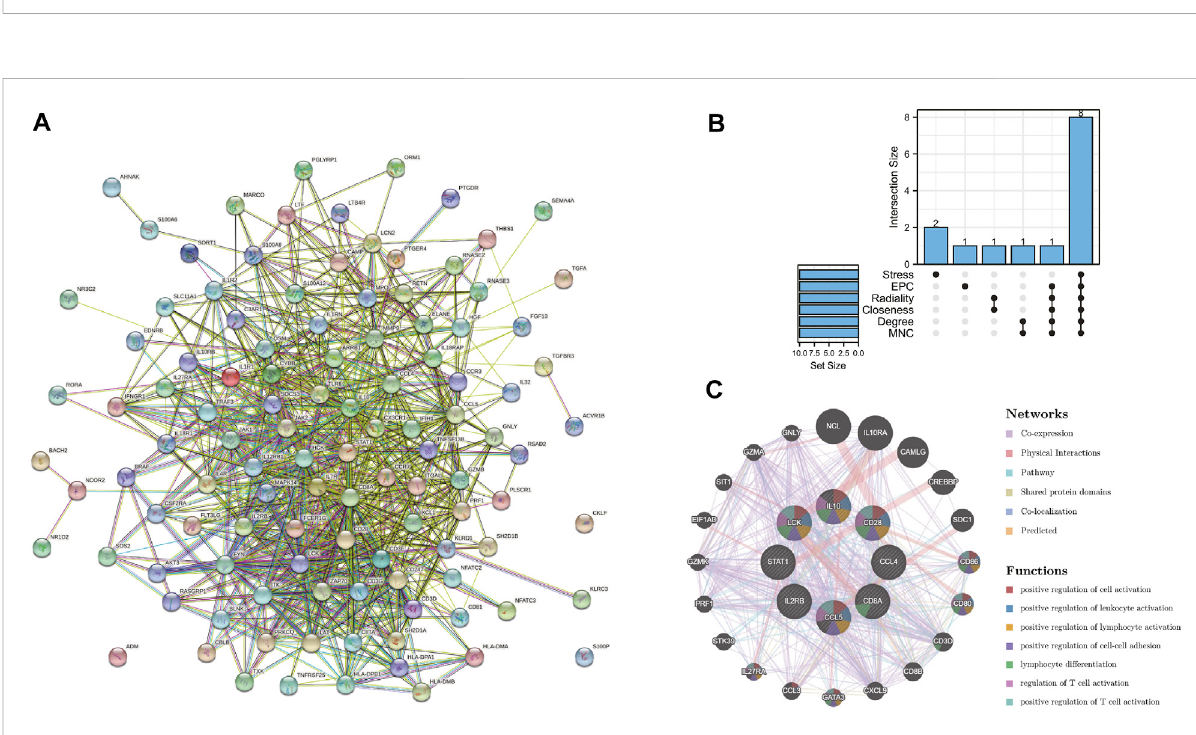
microarray data, of which 24 The cells consist of 18 T cell subtypes and 6 other immune cells: B cells, NK cells, monocytes, macrophages, neutrophils, and DC cells. The sum